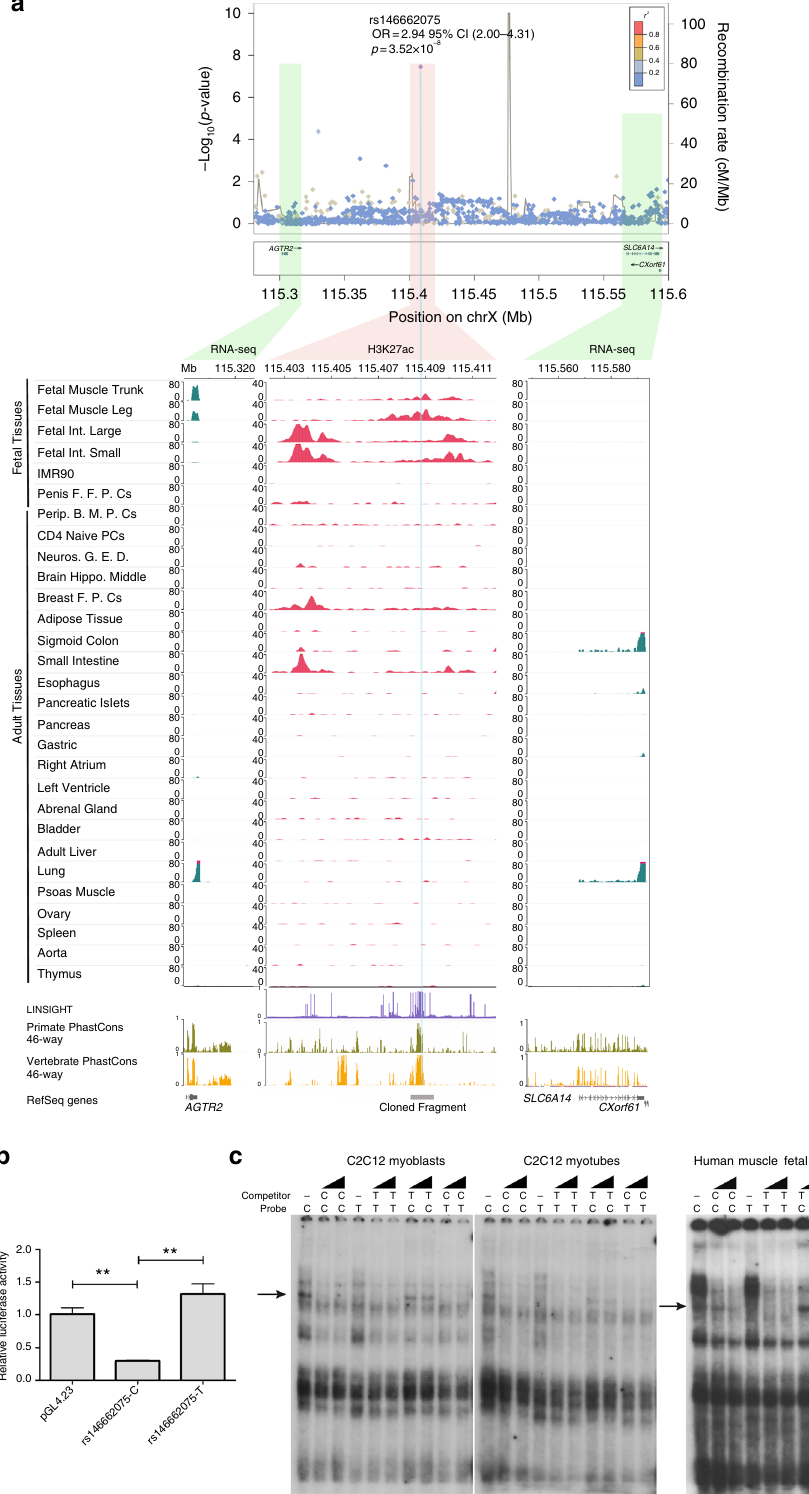
Vertebrate PhastCons